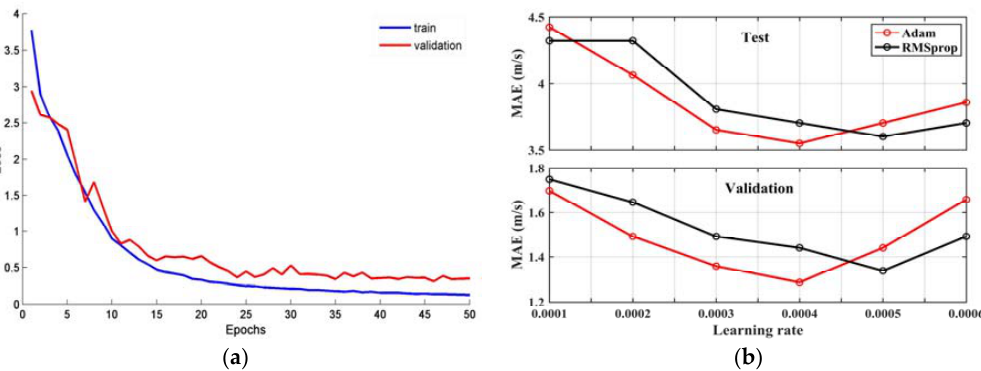
Figure 5. ( a ) Model learning curves: training loss (blue line) and validation loss (red line). ( b ) Model testing and validation results when optimized with Adam (red line) and RMSprop (black line) at different learning rates.